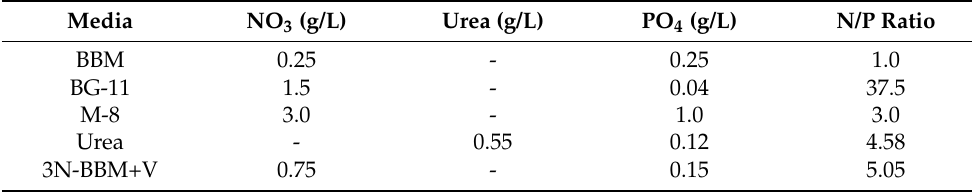
Table 4. Composition of media used in vegetative stage cultivation.